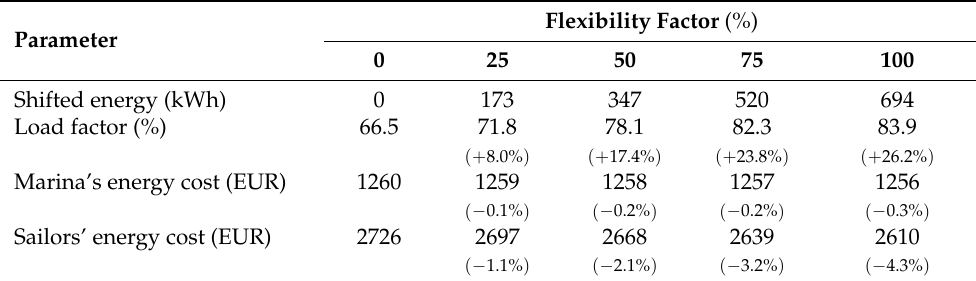
Table 3. Simulation results for different flexibility